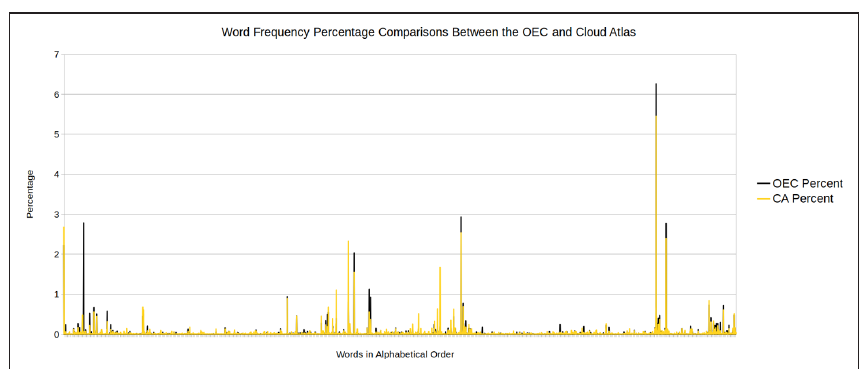
Figure 3: Relative percentage frequency of terms from Ewing Part I (E edition) vs the Oxford English Corpus. Where a yellow line appears higher, the usage in Cloud Atlas is higher than in the OEC. Where a black line appears higher, the usage is higher in the OEC than in Cloud Atlas